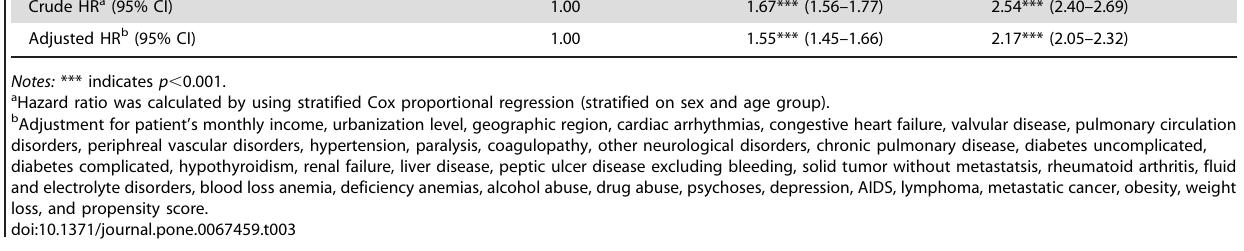
Presence of injury during the 90-day follow-up